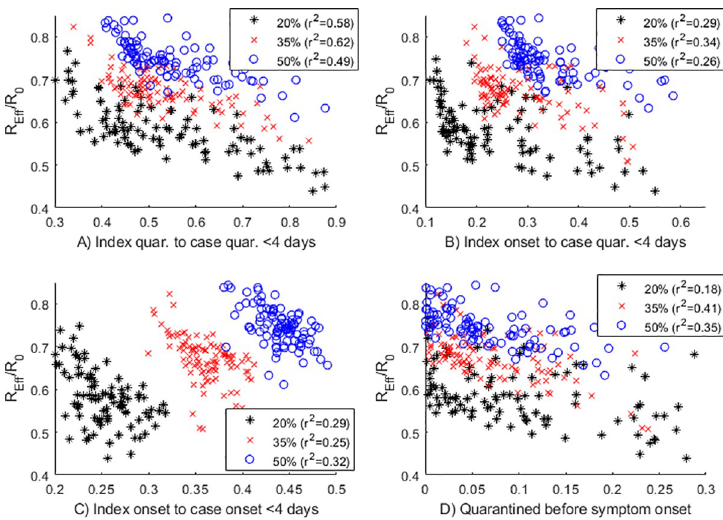
Fig 4. The proportion of cases quarantined or isolated within 4 days of the index case being quarantined or isolated (A) is still the most robust indicator of the performance of the contact tracing system under different levels of presymptomatic transmission (20%, black ‘ � ’, 35% red ‘x’, 50% blue ‘o’). Other indicators (B)-(D) are not reliably correlated with R across all model parameters. Each plotted point corresponds to a randomly chosen combination of: eff tracing coverage p , tracing speed T , quarantine effectiveness c , isolation effectiveness c , and probability of trace quar iso trace testing for untraced clinical cases p test . Other parameter values shown in Table 1. The horizontal axes show the proportion of cases meeting the specified performance